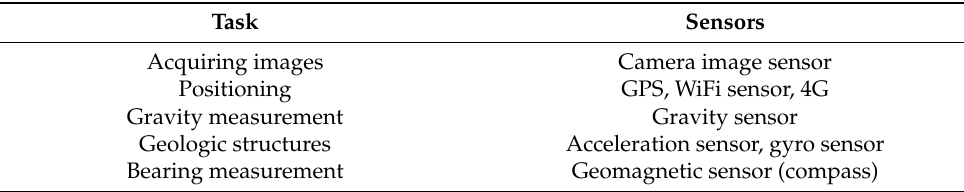
Table 3. Sensors used in KMapper.